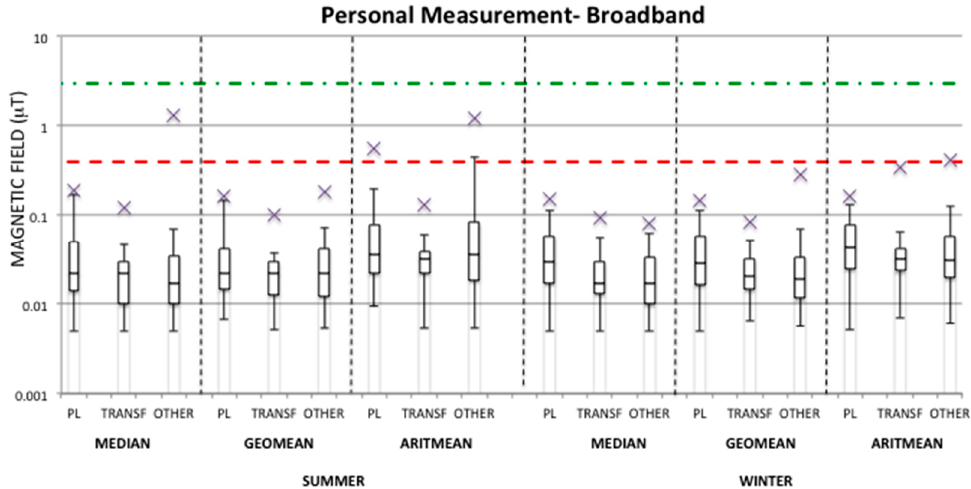
Figure 1. Distribution of the median, geometric mean (geomean), and arithmetic mean (aritmean) of the magnetic field ( µ T) in the broadband frequency range (40–800 Hz) indicated as a box-plot for personal measurements for each group (PL, TRANSF, OTHER) in both summer and winter periods. The bars represent the 25th percentile, median, and 75th percentile values, while the whiskers are the minimum and 95th percentile values. The star represents the maximum value. The red dashed line is at 0.4 µ T. The green dot-dash line at 3 µ T is the 24-h median value established by Italian law [36] as the quality target. The distribution values are indicated in Appendix Table A1.